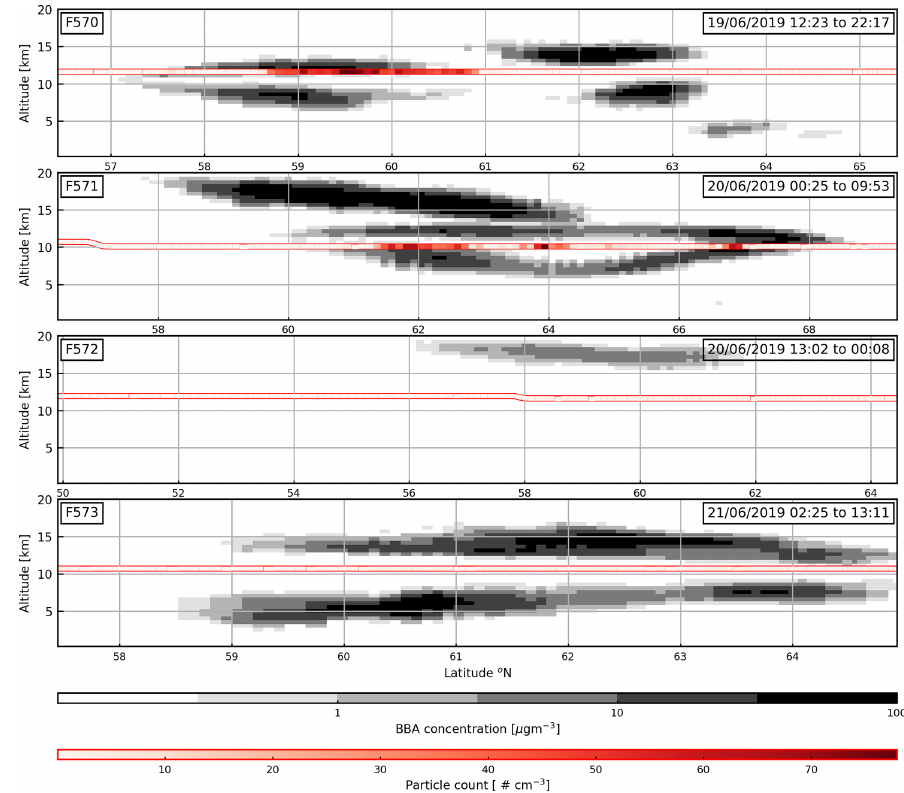
Figure 9. NAME air concentration data [µgm − 3 ] along the CARIBIC tracks shown in Fig. 6. Overlaid are the CARIBIC flight paths coloured to show the particle count [numbercm − 3 ] recorded by the Grimm OPC. The NAME data are a mean of the 1h output files corresponding to the time the aircraft was transiting the aerosol cloud (times shown in